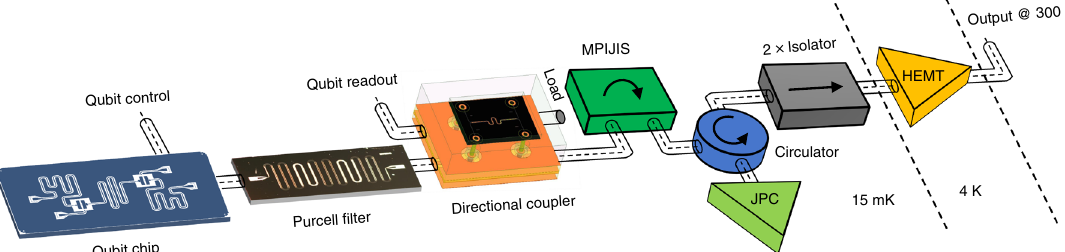
Fig. 3 Rapid, high- fi delity, QND measurement setup incorporating the MPIJIS device. The setup, exhibiting only the main components, includes a two-qubit chip in which only one qubit is measured. The measured qubit is read through a single-port, fast readout resonator and controlled via a separate line, which is capacitively coupled to the qubit. To prevent the qubit from relaxing through the readout resonator, a Purcell fi lter is added to the resonator port, which connects to the rest of the setup. To enable a re fl ective measurement of the qubit without utilizing a circulator, a broadband, on-chip directional coupler is incorporated between the Purcell fi lter and the readout input line. In this con fi guration, the readout signals input on the directional coupler couple, with about 20 dB of attenuation, to the Purcell fi lter (and readout resonator), whereas the output readout signals re fl ecting off the readout resonator